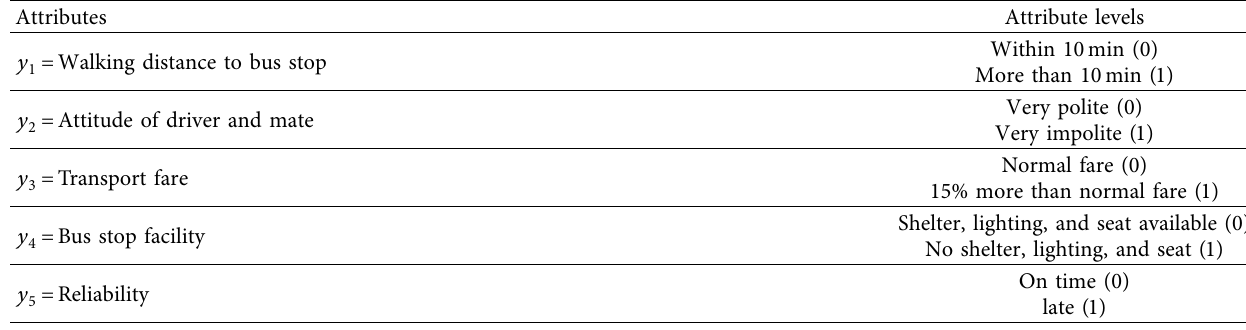
Table 9: Attributes and their levels included for the SCE.